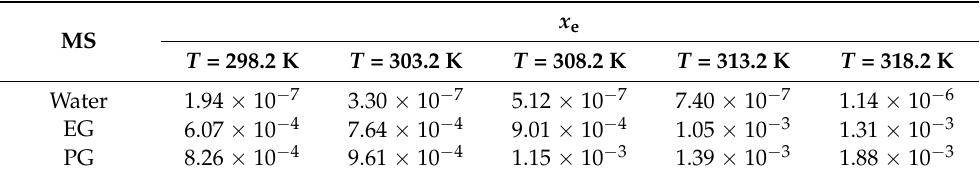
Table 1. Experimental solubilities ( x e ) and ideal solubilities ( x idl ) of febuxostat (FBX) in mole fraction in various mono solvents (MS) at 298.2–318.2 K and 101.1 kPa a . x e MS T = 298.2 K T = 303.2